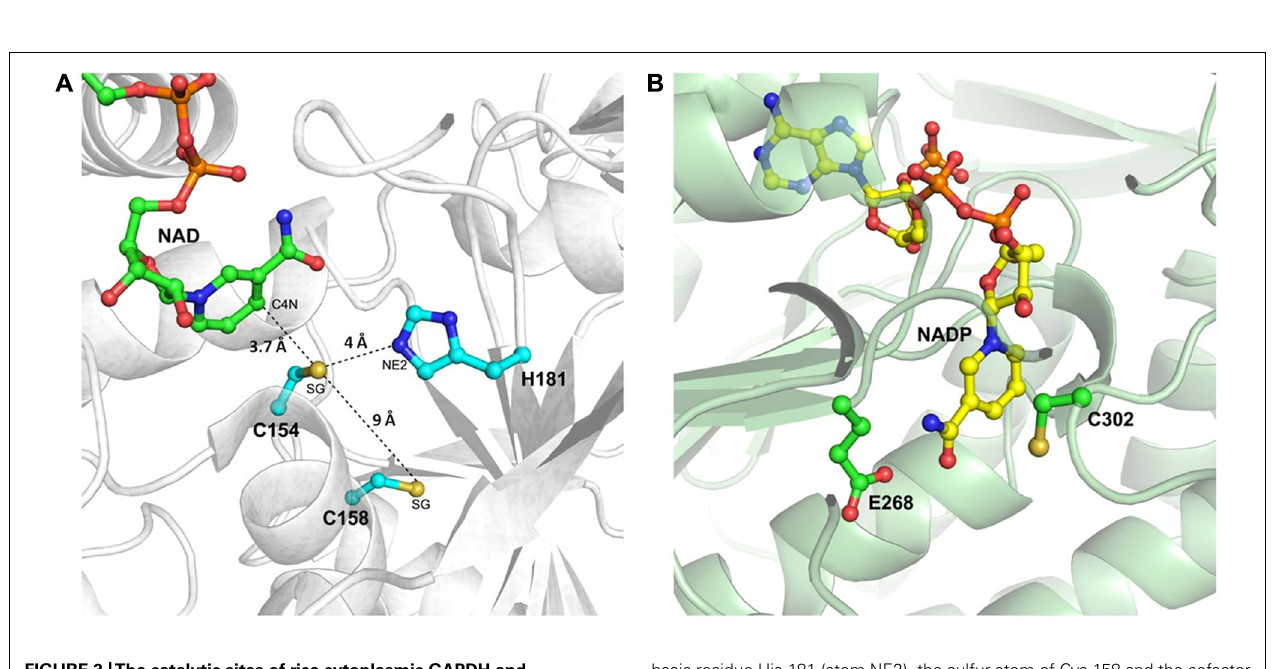
basic residue His-181 (atom NE2), the sulfur atom of Cys-158 and the cofactor (atom C4N) are indicated by dashed lines. (B) Catalytic site representation of Streptococcus mutans non-phosphorylating GAPDH (SmGAPN; PDB code 2EUH).The catalytic residues Cys-302 and Glu-268, and the cofactor NADP + are in ball-and-sticks